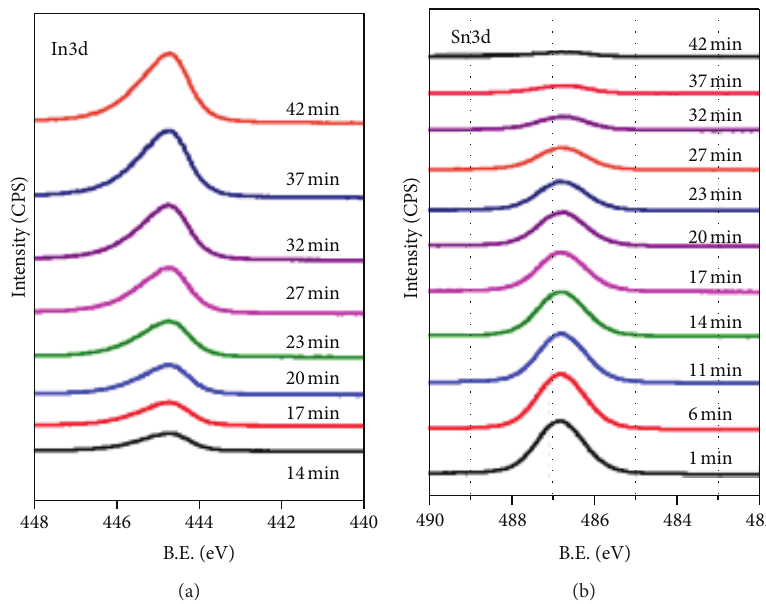
complex layers. 2